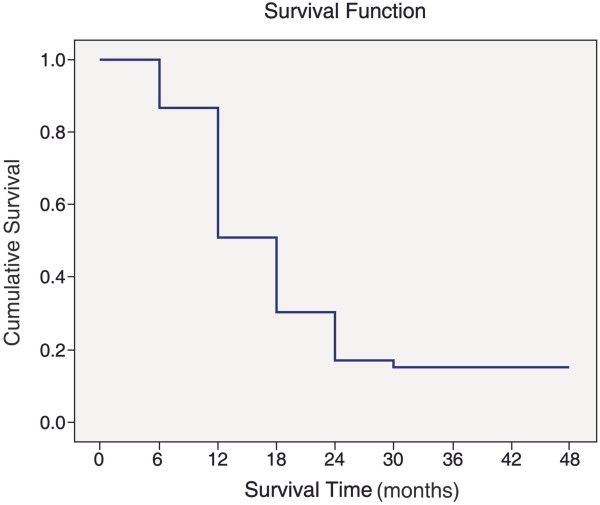
Survival for all patients.